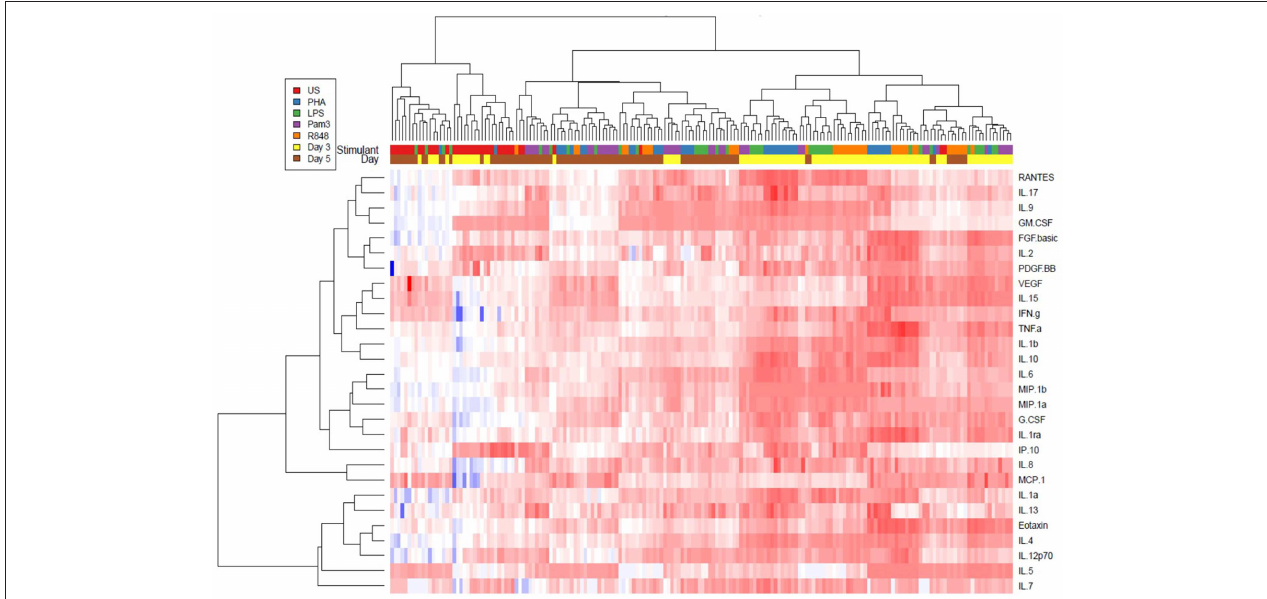
FIGURE 3 | Unsupervised hierarchical cluster heat map analysis of 28 cytokines measured in cell culture supernatants on day 3 (yellow) and day 5 (brown) from the unstimulated (red), PHA (blue), LPS (green), Pam3CSK4 (purple), or R848 (orange) conditions. PHA was used at a final concentration of 10 µ g/ml. TLR agonists were used at a final concentration of 2 µ g/ml. Sample size, n = 5, 4 donors run in quadruplicate, 1 donor run in